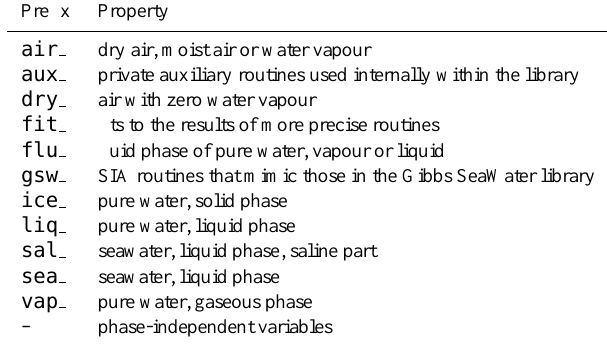
Table 1. Summary of prefixes used on procedure names to indi- cate the substance, phase or special purpose that they are associated